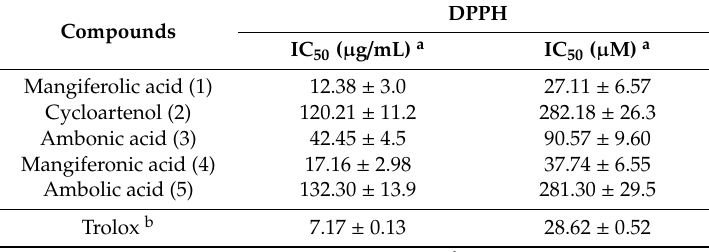
Table 3. Antioxidant activity of isolated compounds from the ether fraction of T. sapiens